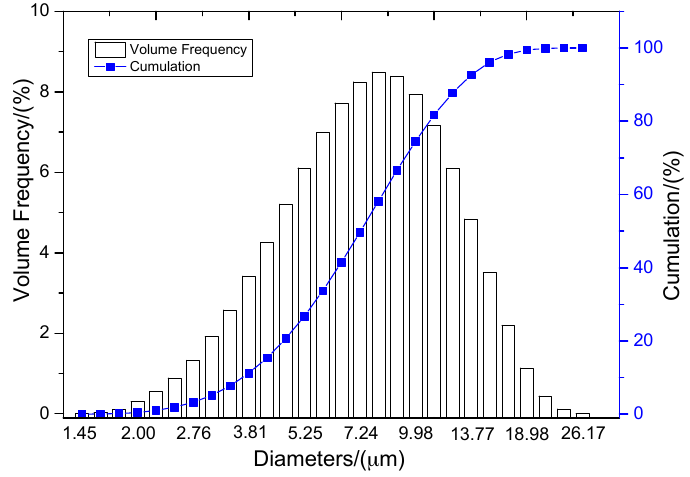
Figure 2. Distribution of aluminum particle diameters.